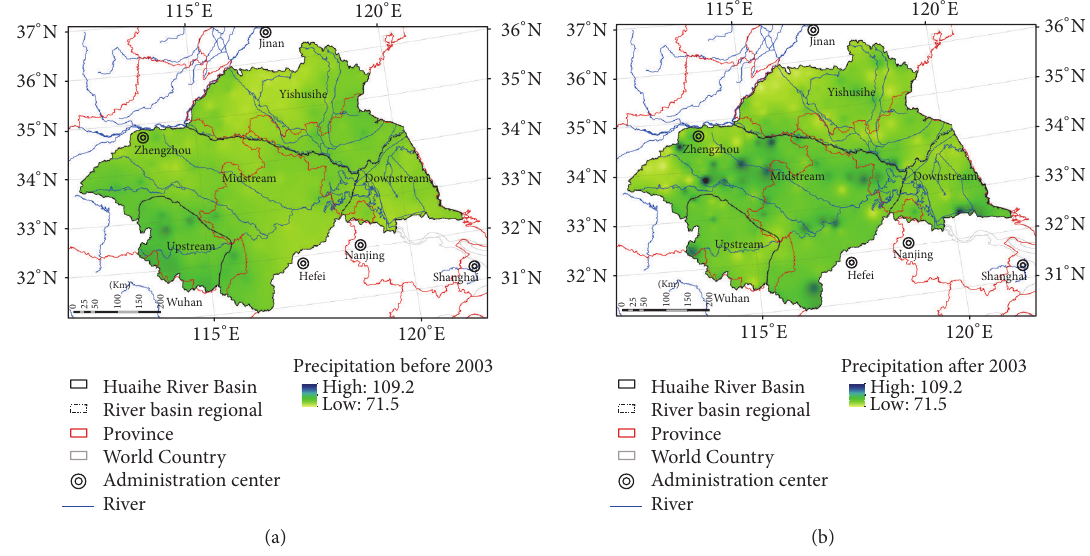
Figure 12: Spatial distribution of isolated rainstorm event precipitation, before and after mutation time.